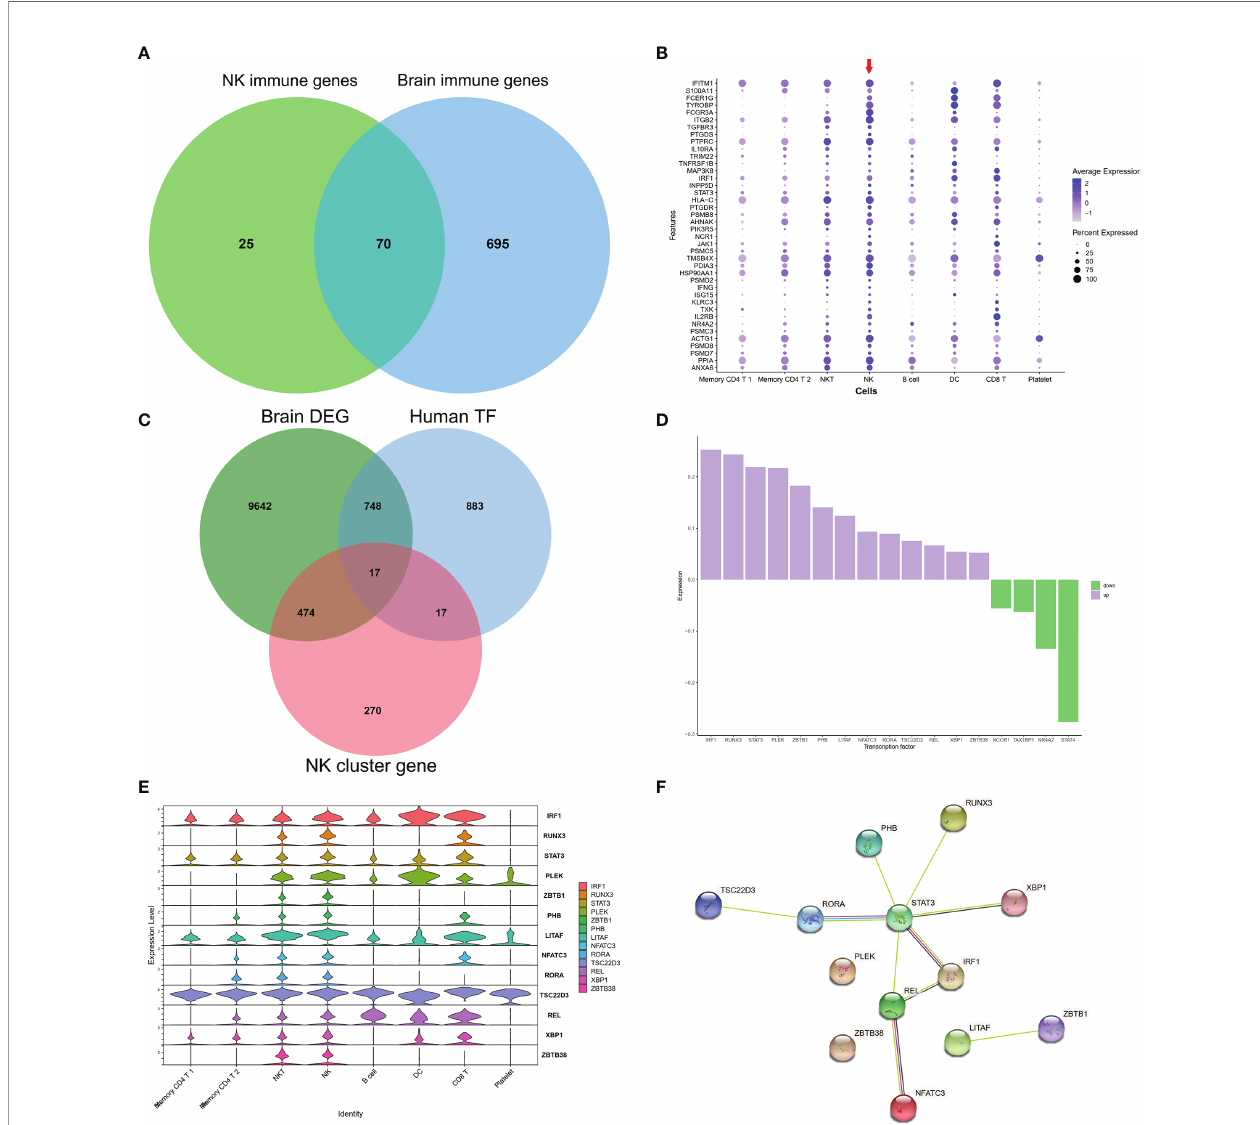
FIGURE 5 | Common IRGs and relevant regulatory transcription factors. (A) Venn plot showed IRGs of NK cluster from PBMC in GSE181279 and IRGs in DEGs of AD brains in GES33000. A total of 70 common IRGs were found in both PBMC NK cluster and AD brains. (B) Dot plot of top 40 common IRGs in PBMCs. The red arrow dictates NK cluster from PBMC in GSE181279. (C) Venn plot showed TFs in NK cluster from PBMC in GSE181279, Human TF database, and TFs in DEG of AD brains in GES33000. (D) The expression of common TFs in DEG of GES33000. Up-regulated TFs were colored in purple, and down-regulated TFs were colored in green. (E) The expression of common TFs in AD PBMCs. (F) The PPI network of the common TFs illustrated using STRING. STAT3 serves as a hub